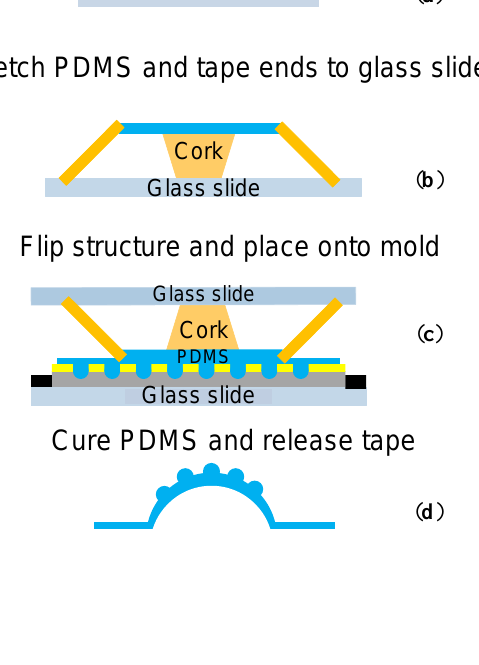
Figure 4. Fabrication process of compound eye. ( a ) Uncured PDMS is flowed on top of plastic hemispherical shell and allowed to cure. ( b ) PDMS hemisphere is placed on top of the cork and stretched until it matches the diameter of the cork. ( c ) Uncured PDMS is placed on top of the hydrogel mold fabricated in Figure 2. Stretched PDMS on top of the cork is then flipped on top of the hydrogel mold. ( d ) Cured PDMS is peeled off from hydrogel mold. The cork is removed which released the stretched PDMS into its original hemispherical